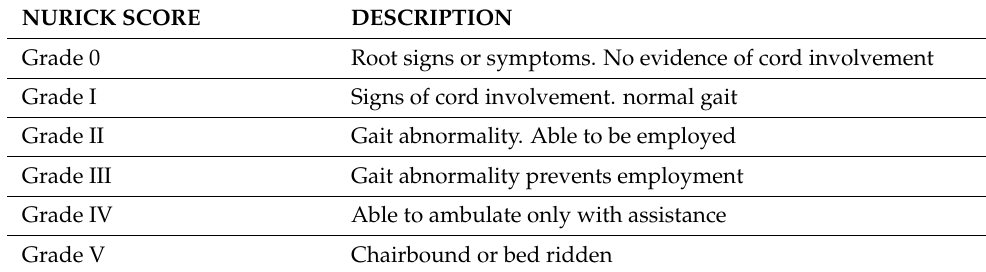
Table A2. Nurick score and description of abnormalities